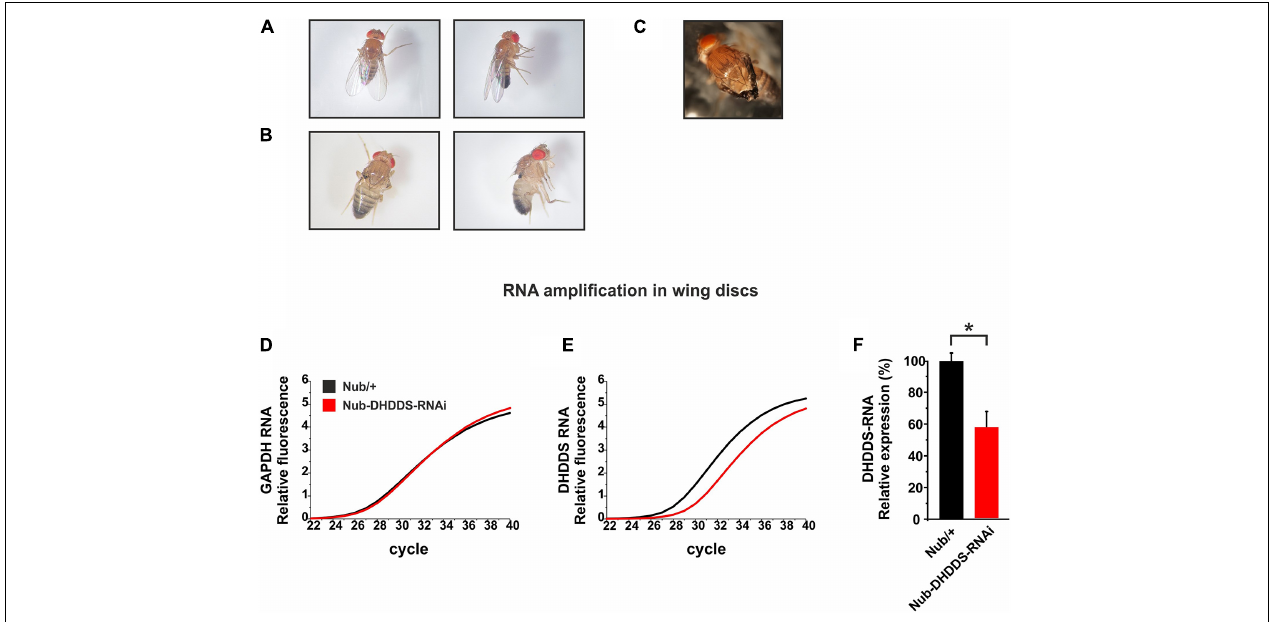
FIGURE 2 | Knockdown of DHDDS in the developing wing primordium resulted in a complete wing loss. Nub-Gal4 flies were mated with either w 1118 or UAS-DHDDS-RNAi flies (VDRC #104188). (A,B) Representative photographs taken under a stereo-microscope of the wings of F1 progenies, females (left) and males (right). (A) Nub/+ control flies. (B) Nub-DHDDS-RNAi flies showing wing absence, indicating that DHDDS is essential for wing formation. (C) A different UAS-DHDDS-RNAi line with a weaker phenotype. Nub-Gal4 flies were also mated with UAS-DHDDS-RNAi flies of a different line (VDRC #3166). The F1 progenies showed a weaker wing phenotype having twisted wings. (D–E) A graphical representation of the significant decrease in DHDDS mRNA levels following its RNAi-mediated knockdown in the wing imaginal discs. q-RT-PCR analysis of DHDDS mRNA expression levels in wing discs of control (Nub/+, black) and experimental (Nub-DHDDS-RNAi, red) third instar larvae. (F) Average expression of DHDDS mRNA in wing discs of experimental group (Nub-DHDDS-RNAi, red), relative to the control group (Nub/+, black). q-RT-PCR analysis was done using the Comparative threshold Cycle quantification that was used to calculate differential mRNA. Values were normalized to the control group. Statistical significance (* P ≤ 0.05) was determined using the Mann–Whitney U test in a one-tailed test. Data is presented as mean ± standard error of the mean (SEM), n = 3. The Mann–Whitney U test is a non-parametric test that allows two groups, conditions or treatments to be compared without assuming that values are normally